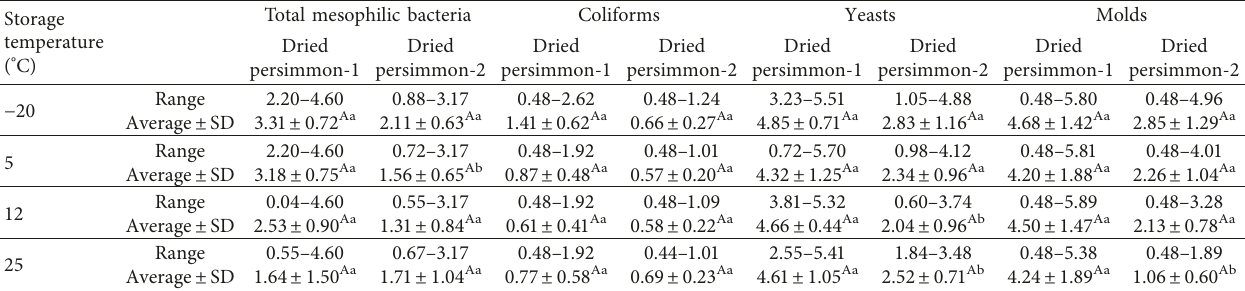
Table 1: Average and range (log 10 CFU/g) of total mesophilic bacteria, coliforms, yeasts, and molds on dried persimmons during storage at different temperatures ( − 20, 5, 12, and 25 ° C) for